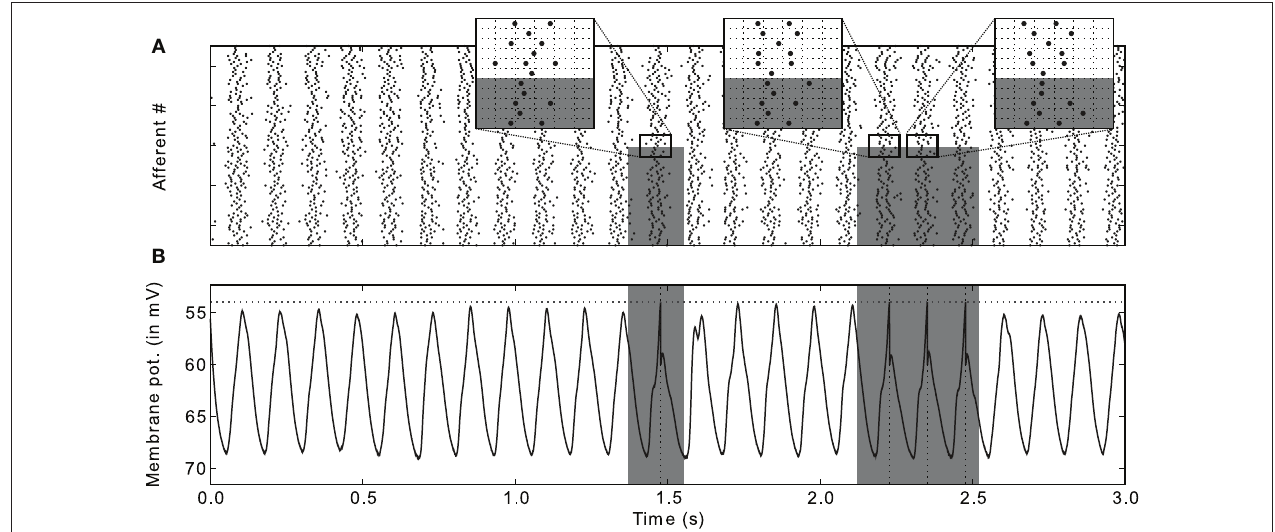
Figure 9 | Downstream neuron’s input and response after learning (A) input spike trains. Spikes come in waves because of the oscillatory drive. Gray rectangles designate the periods where the pattern is presented, and the afferents that are involved in it (bottom half here). Three insets [horizontal grid size = 1 rad (in phase) = 20 ms] zoom on adequate periods to illustrate that the spike phases of